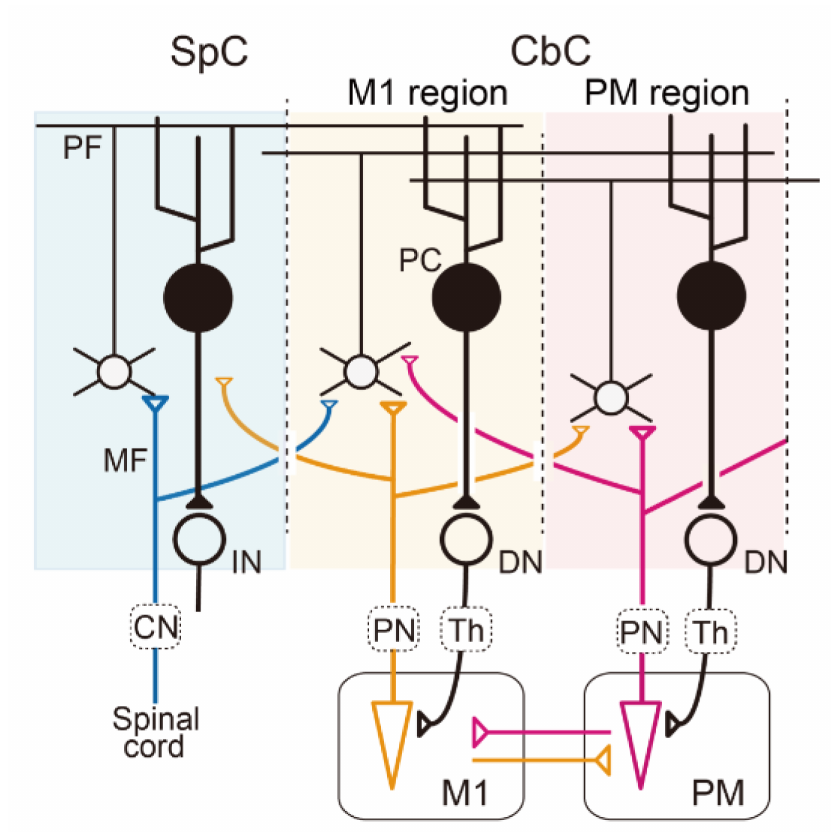
Figure 1. Multiple communication loops with extensive overlaps A: Schematic diagram of the cerebellar circuit. Mossy fiber (MF) inputs from the periphery, the primary motor cortex (M1), and the premotor cortex (PM) are represented by blue, orange, and red lines, respectively. In this diagram, we assume that the sensory afferent and efference copies from the M1are integrated into individual GCs or PCs in the M1 region of the cerebro–cerebellum (CbC). The output from the M1 region of the CbC projects back to the M1 through the dentate nucleus (DN) and the thalamus (Th). CbC, cerebro–cerebellum; CN, cuneate nucleus; IN, interpositus nucleus; PC, Purkinje cells; PN, pontine nuclei; SpC,